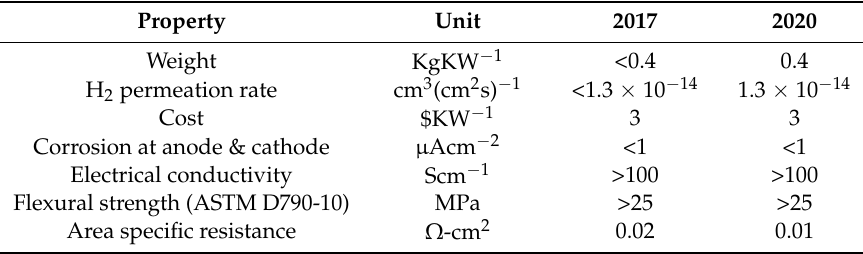
Table 1. DOE technical targets for PEM fuel cells bipolar plates